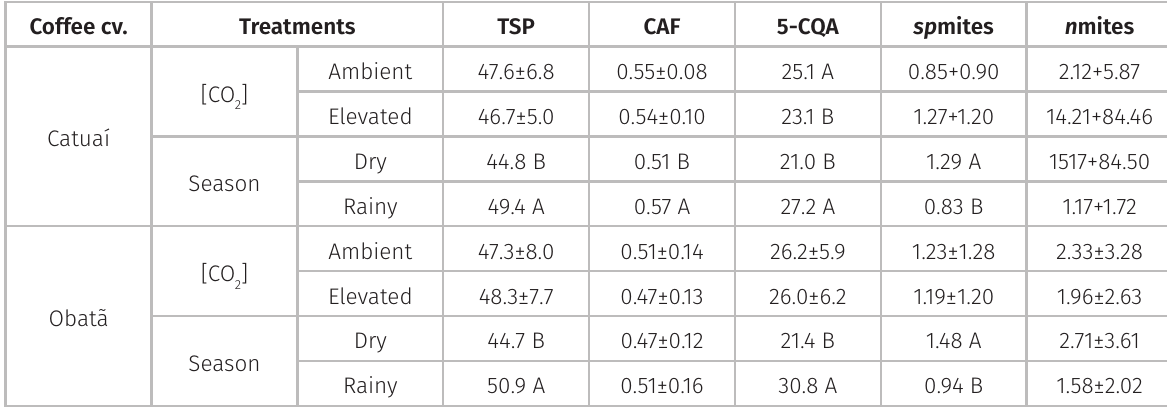
] (elevated/ambient) and leaves 2